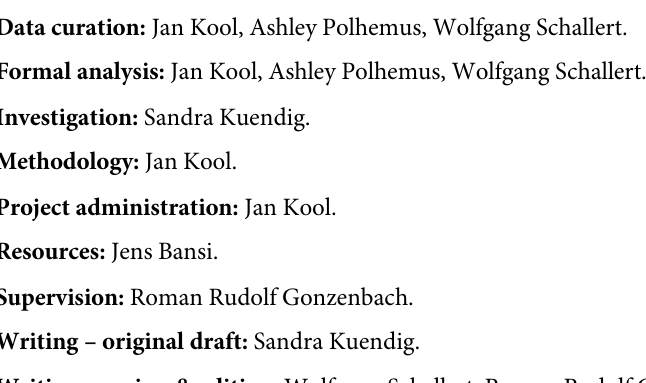
S1 Table. Physical activity. Data is presented as median (min per day). Abbreviations: T0, one week before rehabilitation; T3, one week after rehabilitation; T4, 3-month follow up.